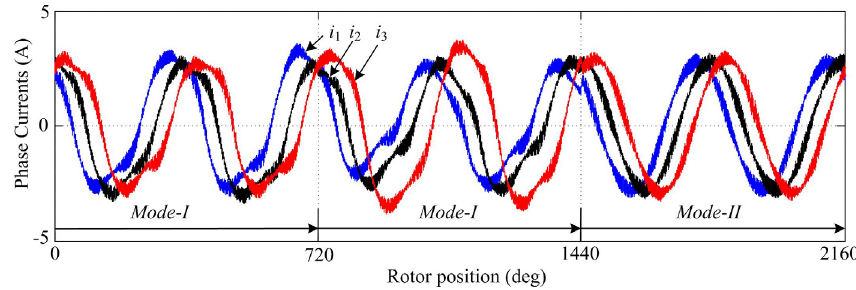
Figure 8. Phase currents in the imbalanced